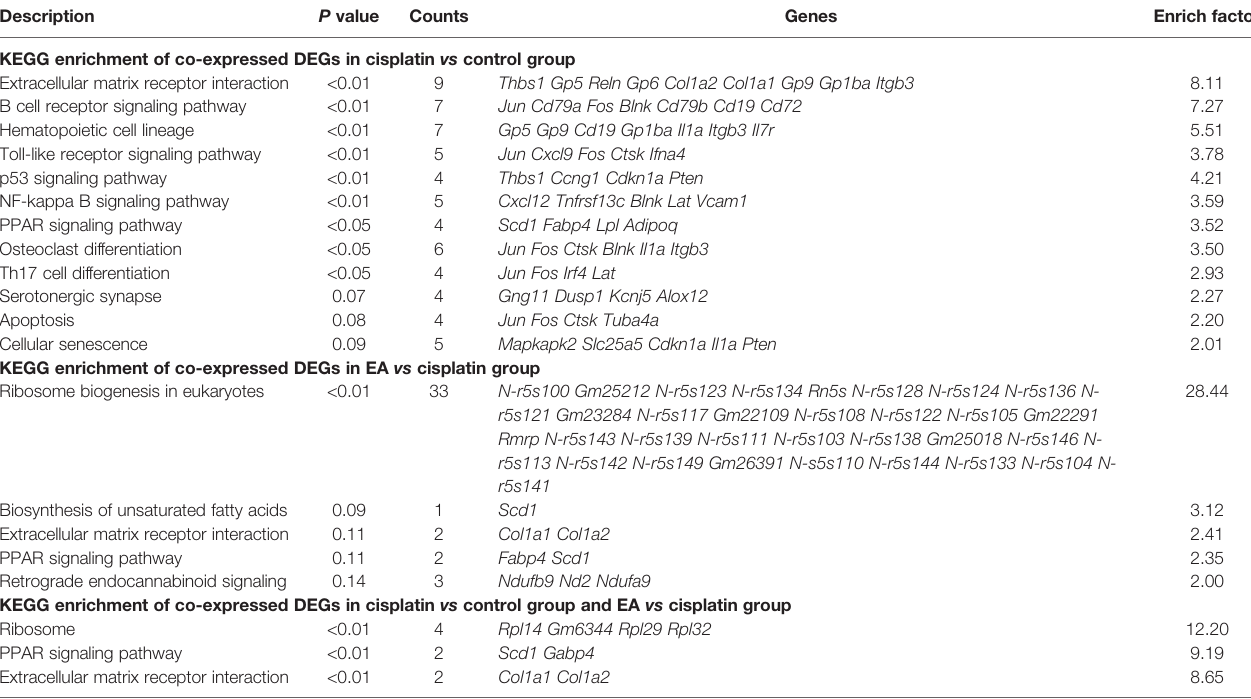
TABLE 1 | KEGG enrichment of co-expressed